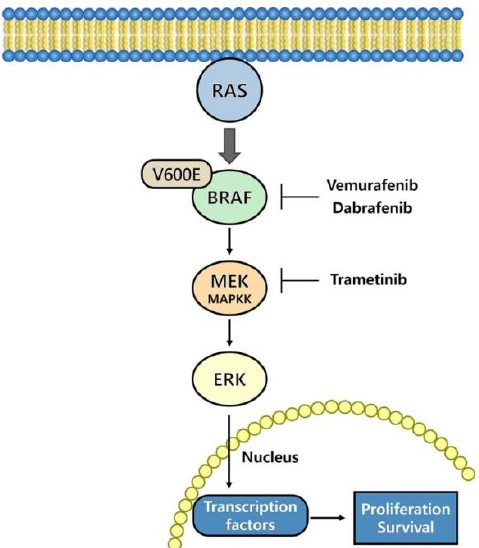
Figure 1. Mitogen-activated protein kinase (MAPK) pathways and BRAF and MAPK/ERK kinase (MEK) inhibitors .